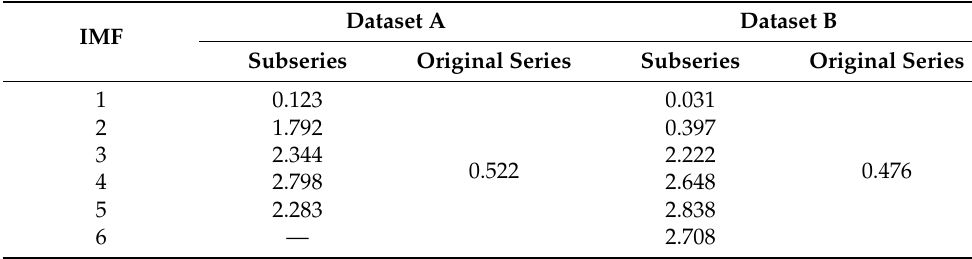
Table 4. Sample entropy of subseries and original